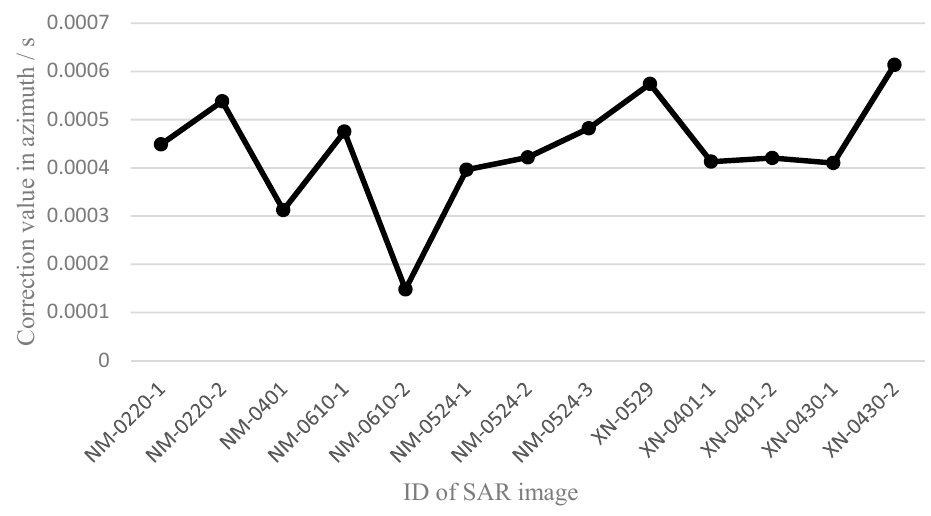
Figure 5. Variation trend of correction values in the azimuth direction.